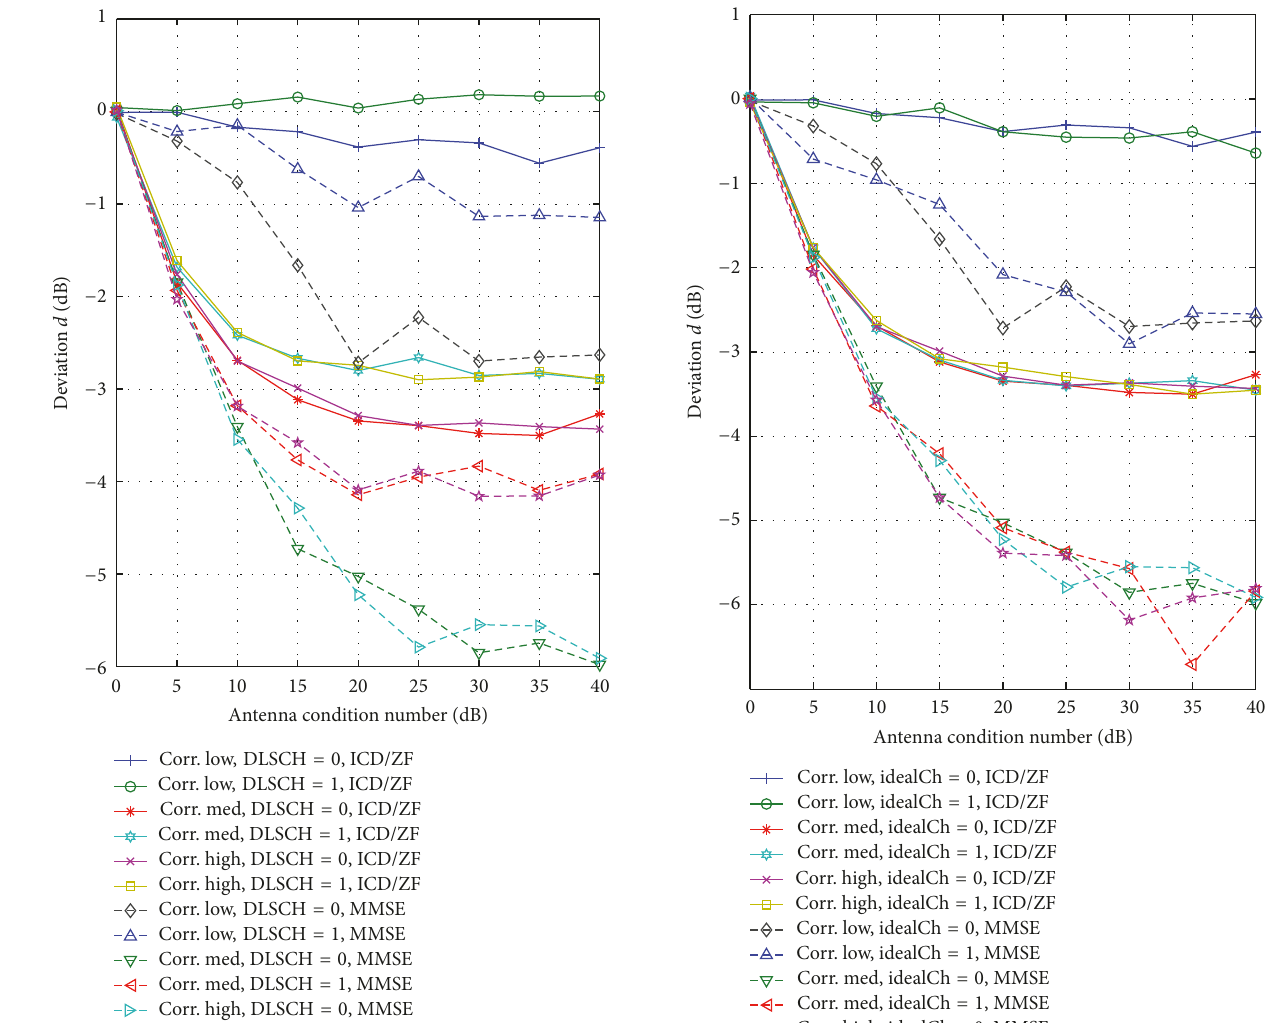
Influence of the Channel Correlation . Figure 11 also points out the differences of the different channel correlations